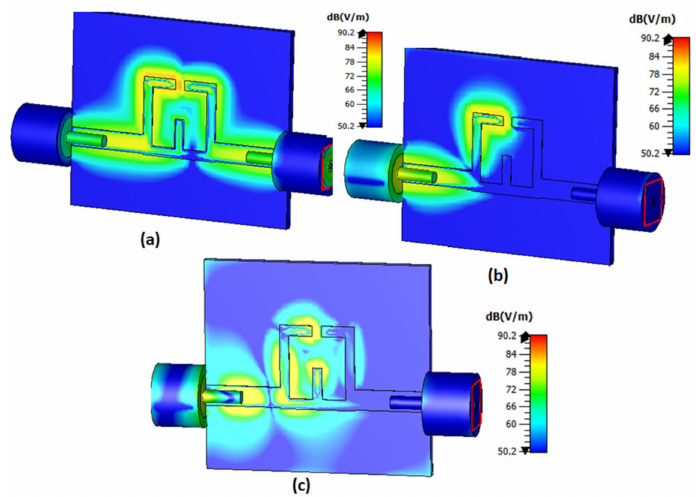
Figure 2. The simulated and measured S-parameters of OLR with a stub.